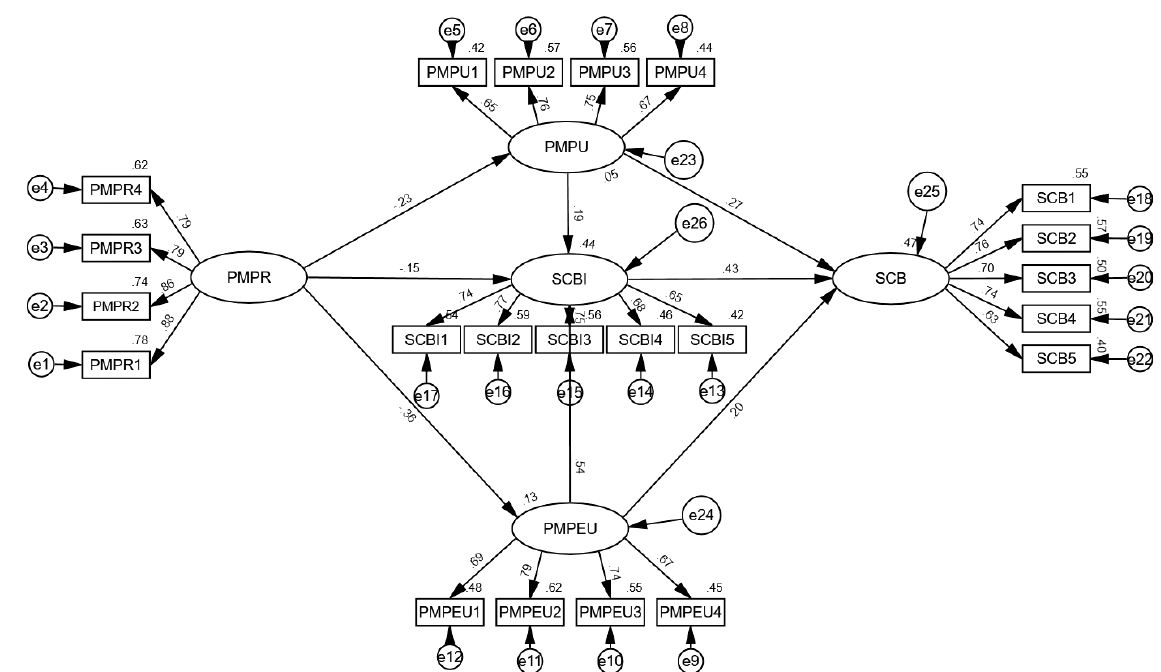
Figure 2. Structural equation model of mobile payment for sustainable consumption